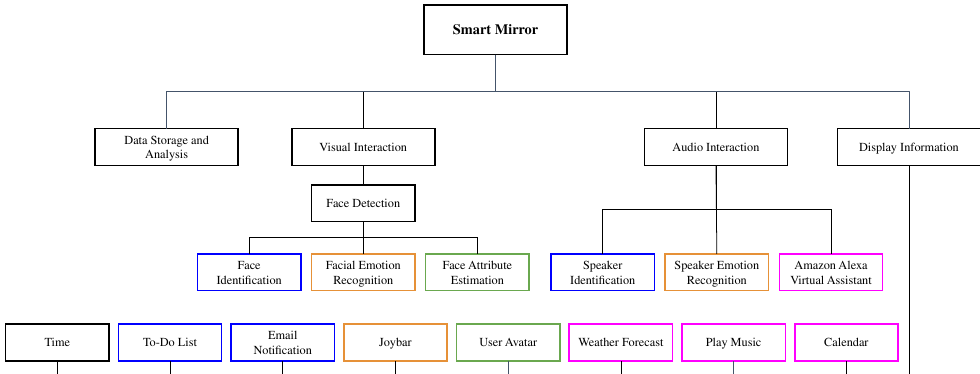
Figure 1. Functional requirements of the proposed smart mirror. Color of boxes indicates relationship between processing modules and information displayed by different applications. For example, to implement user-specific applications, user authentication through face and speaker recognition are required. Applications such as weather forecast, calendar, and music player depend on integration of mirror with Alexa